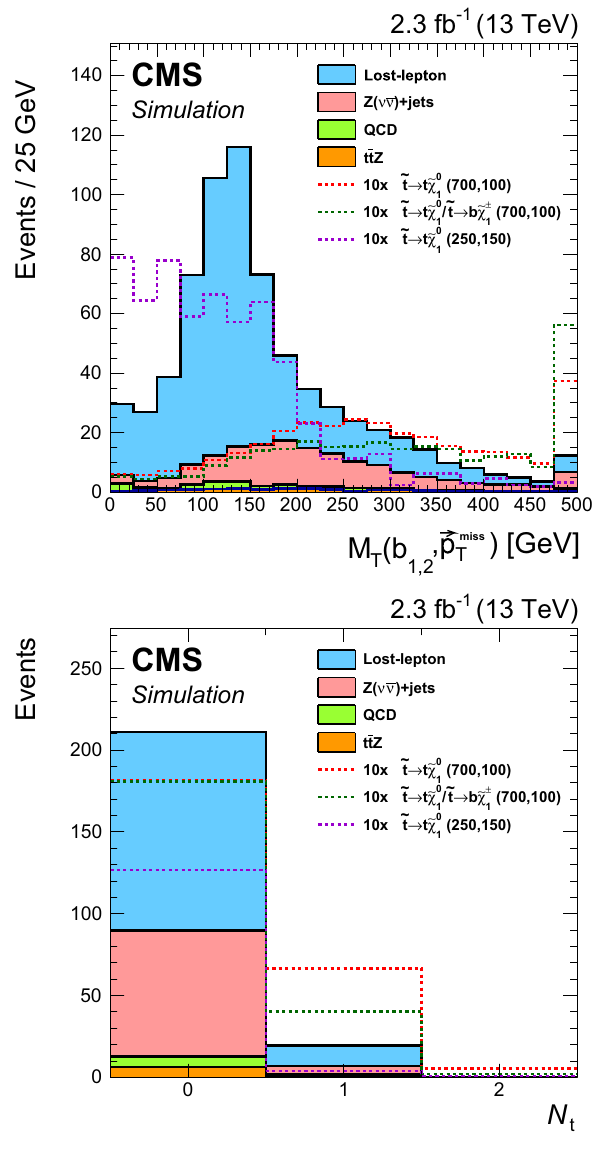
) distribution after the baseline selection of Fig. 2 The M T ( b 1 , 2 , (cid:5) p miss T the top squark search in the all-jet final state ( top ), and the number of ) category reconstructedtopquarksforeventsinthehigh- M T ( b 1 , 2 , (cid:5) p miss T ( bottom ). Signal models with different top squark and neutralino mass hypotheses are shown, with the first number indicating the assumed top squark mass in units ofGeV and the second the neutralino mass. The expected signal yields are scaled up by a factor of 10 to facilitate com- parison of the distributions with expectations from SM backgrounds. In this and subsequent figures, the last bin shown includes the overflow events